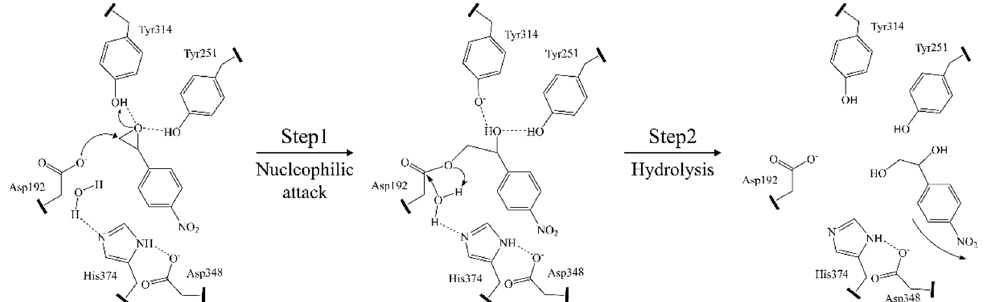
Figure 2. Mechanism of a typical α / β hydrolase, 4-nitrostyrene oxide hydrolase An EH. Reprinted with permission from Ref. [22] . Copyright 2000, Elsevier.